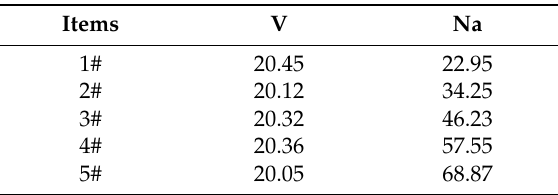
Table 1. Main chemical composition of the simulated feed vanadium solutions with different sodium ions concentrations, g/L.